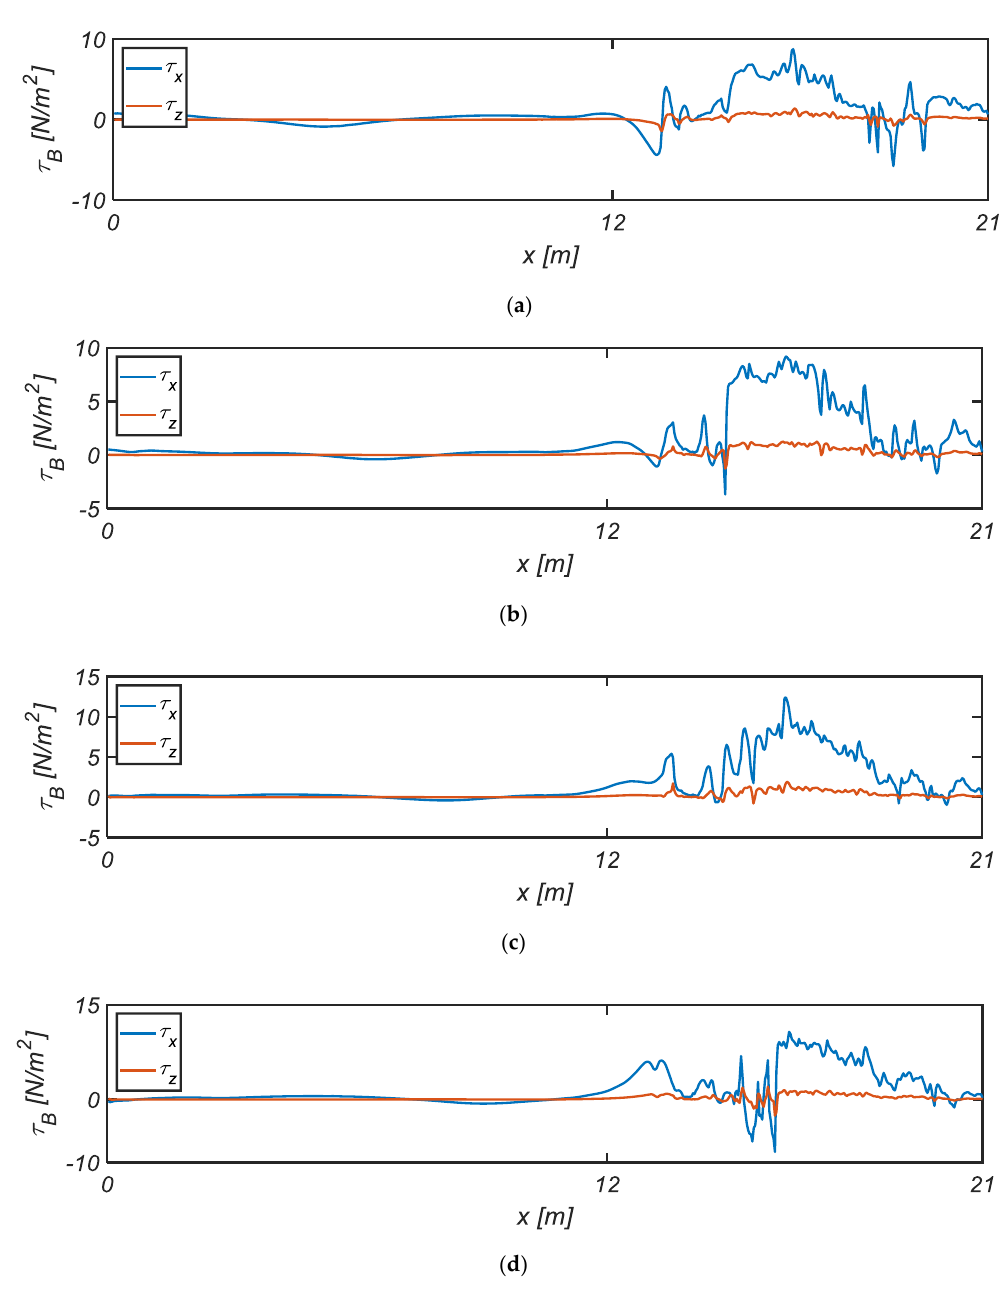
Figure 12. Temporal variation of the bottom shearing stress at Gauge NO. 1, 2, 3, and 4 [Run 2].